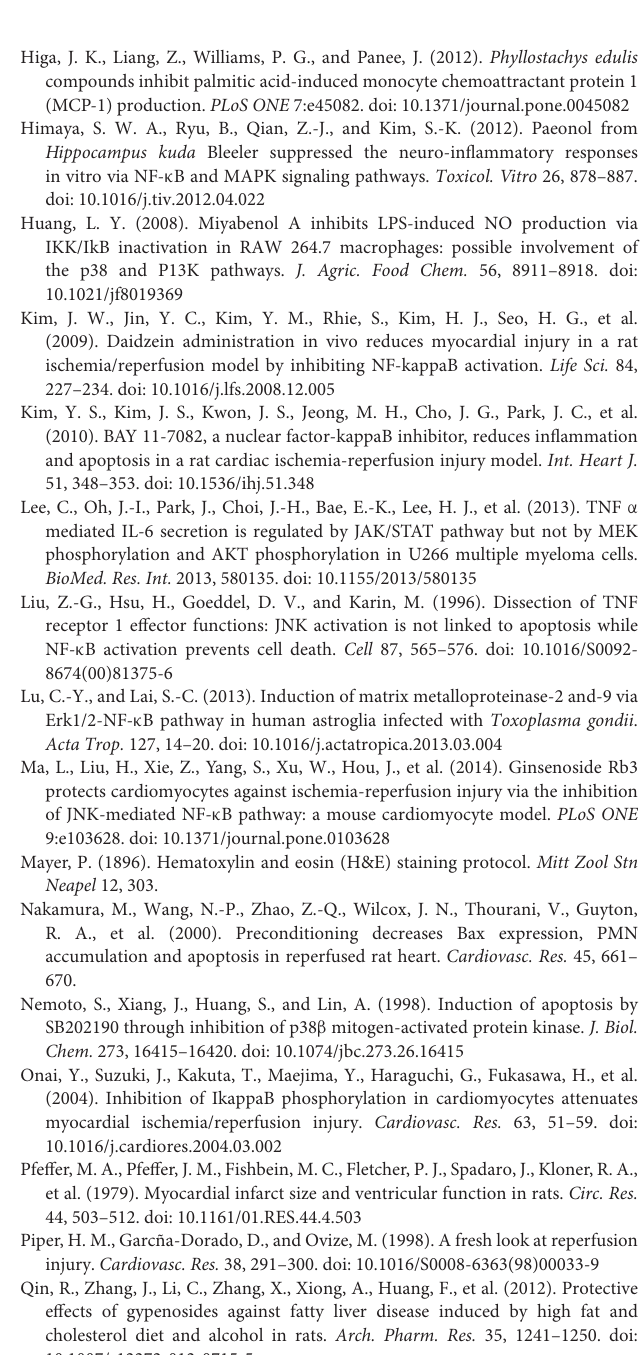
FIGURE S1 | General structure for dammarane-type gypenosides (where R1 ¼ glucose, rhamnose; R2 ¼ glucose, rhamnose, etc.; R3 ¼